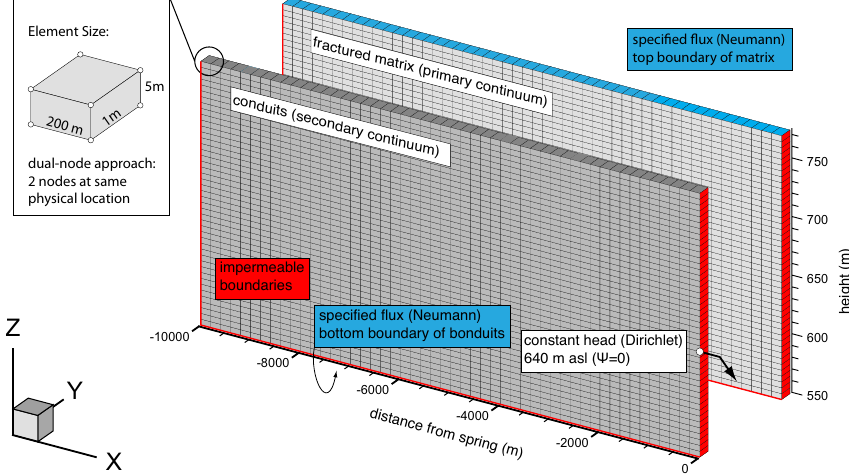
Fig. 3. Model grid of the two-dimensional model. A constant head boundary is applied at 640m in the second continuum. Recharge is applied along the top boundary in both continua. Every node in the primary continuum has its counterpart in the secondary continuum at the same physical location.